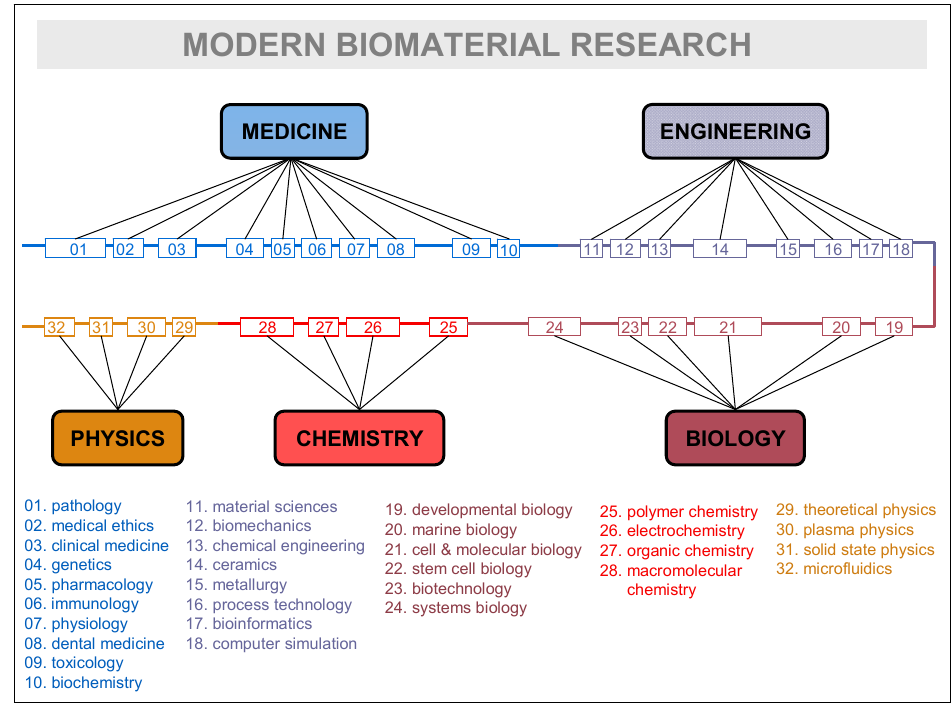
Figure 3. Disciplines involved in modern biomaterial research. The representation is based on the description made by bioengineer James Kirkpatrick